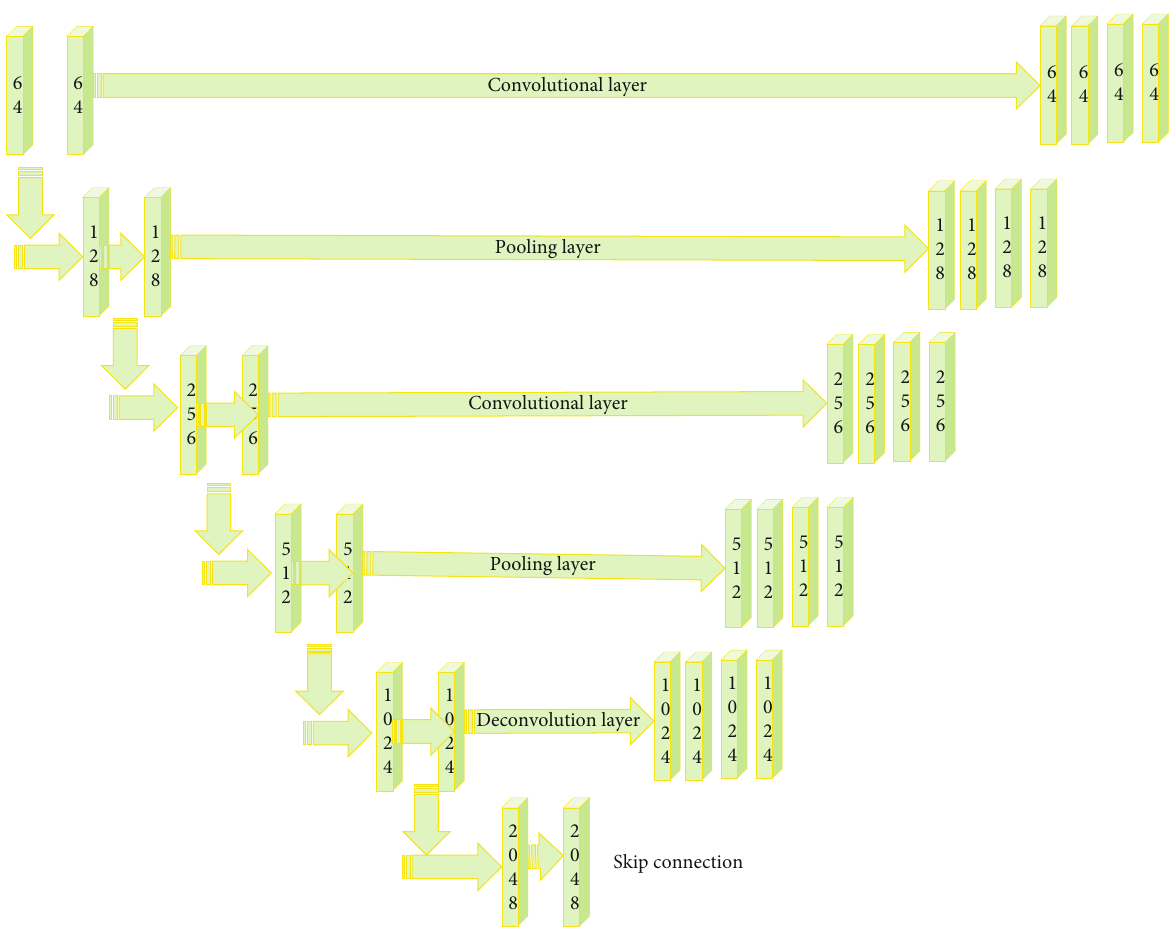
Figure 2: Schematic diagram of U-net